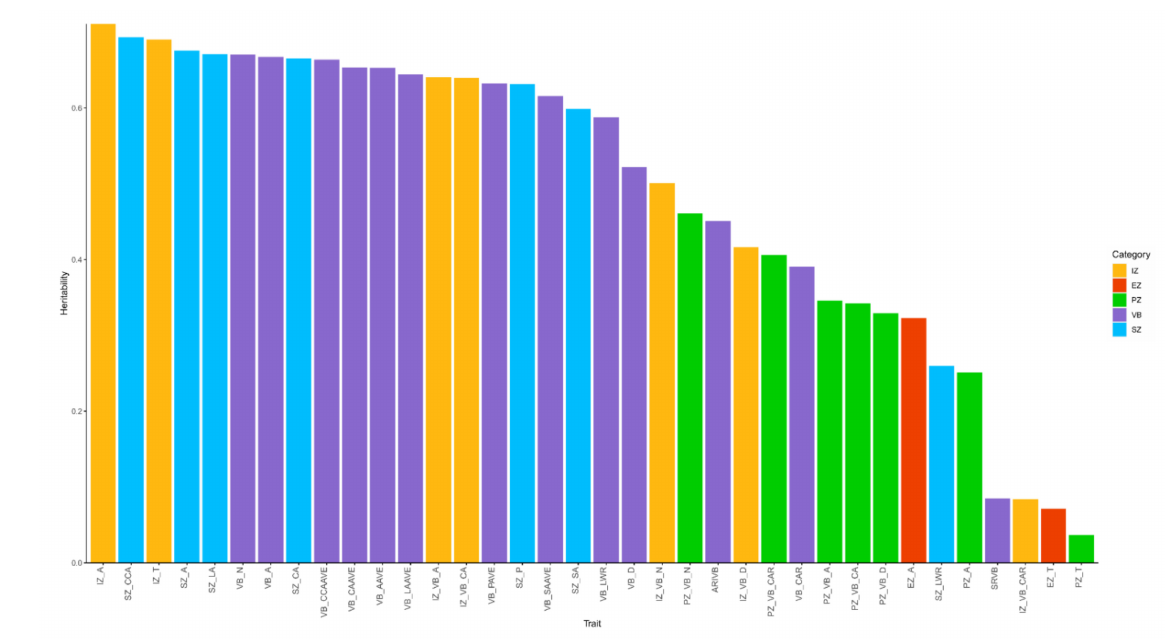
Figure 3. The heritability ( H 2 ) of the investigated 36 phenotypic traits of maize shank. Yellow columns represent inner zone-related traits (7 items), red columns represent epidermis zone-related traits (2 items), green columns represent periphery zone-related traits (7 items), purple columns represent vascular bundle-related traits (12 items), and blue columns represent cross-section-related traits (7